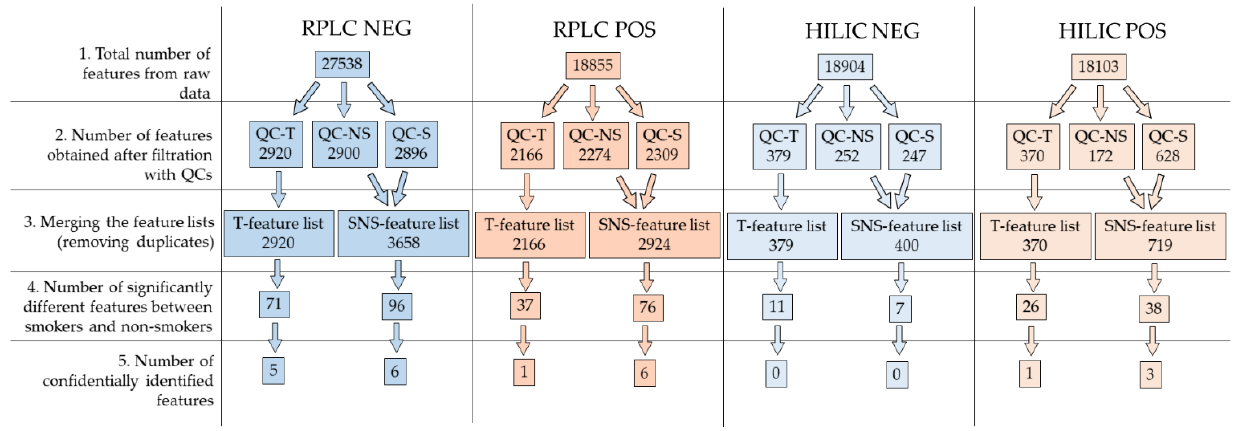
Detailed information about the compounds is reported in Supplementary Table S1.